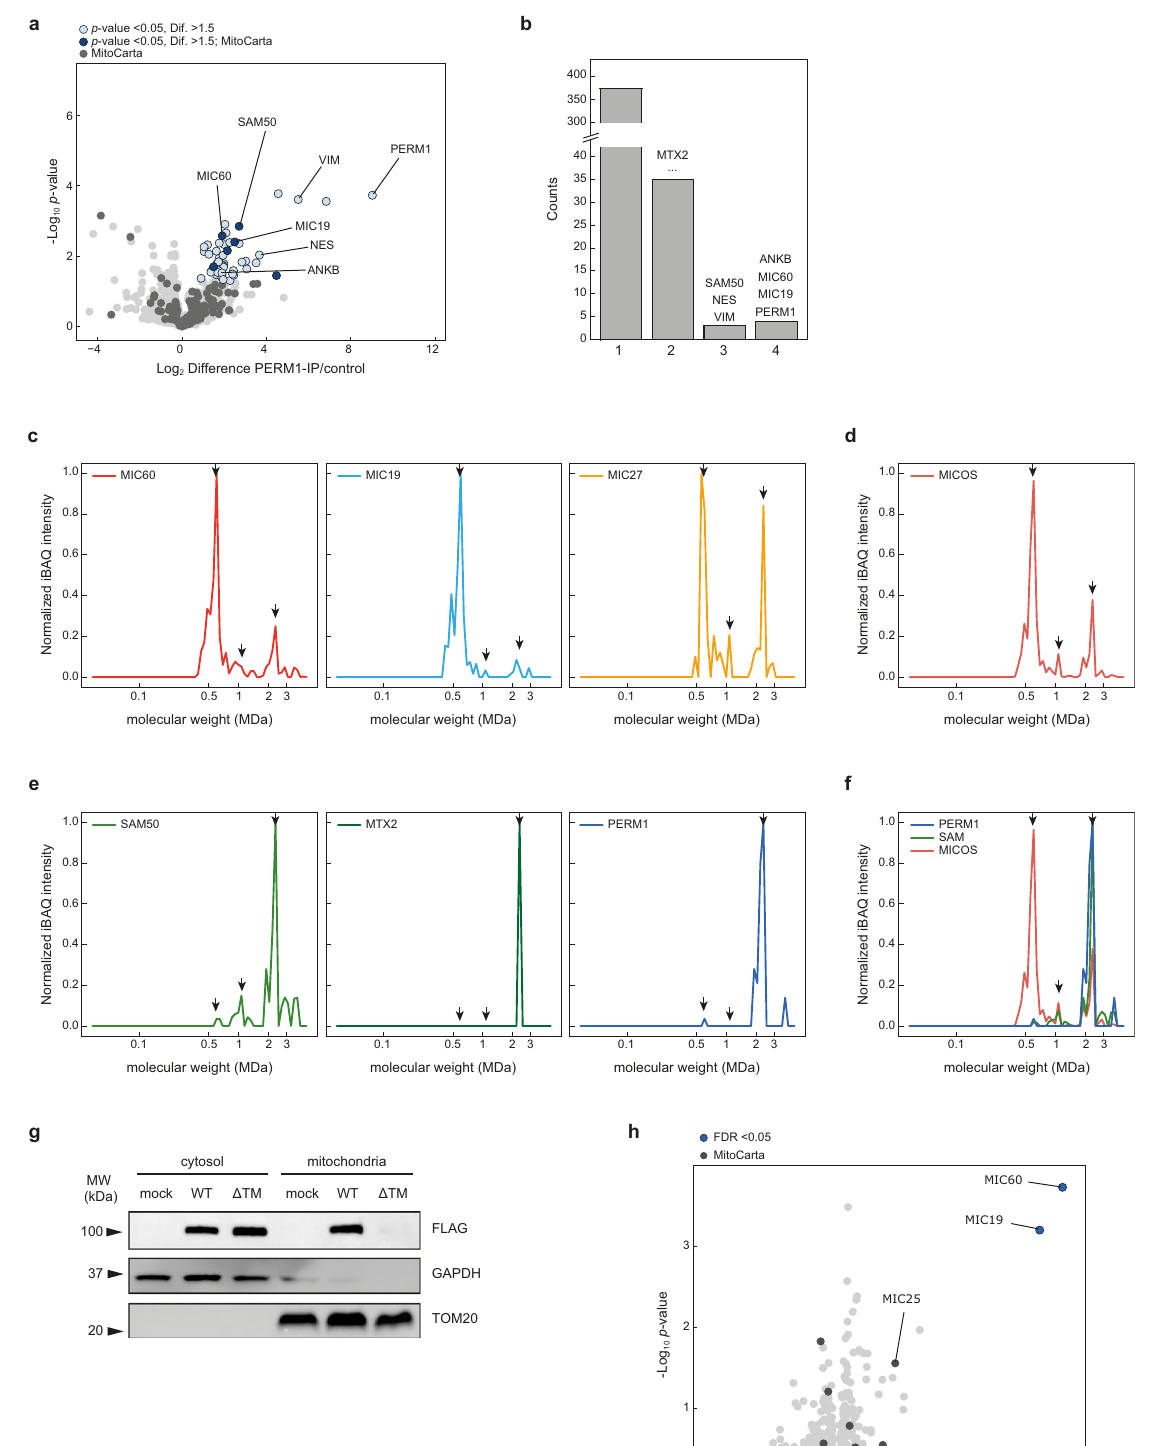
protein abundance of this transporter in Perm1 − / − mitochondria (SI Fig. S4a, b). Detection of ankyrin B (ANKB or ANK2) and the intermediate fi lament proteins vimentin and nestin suggest that PERM1 connects the OMM to cytoskeletal structures.